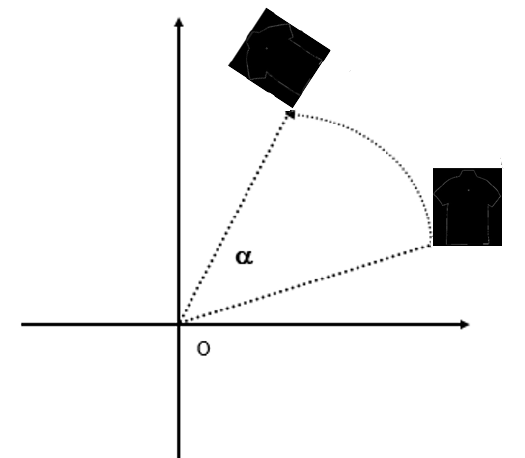
Figure 11. Definition of rotated centre and angle for Affine Transformation.